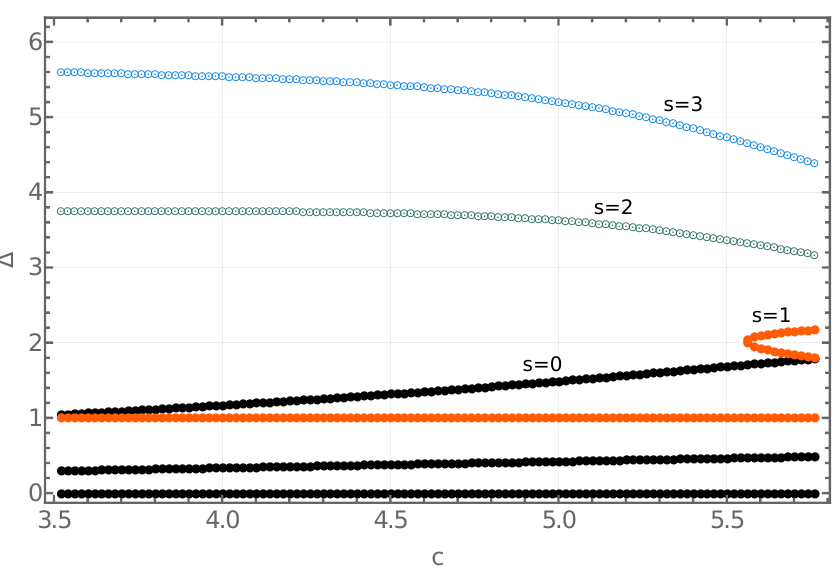
Figure 2 . Roots of the extremal functional evaluated at increasing values of the central charge. Single roots are denoted by filled circles and double roots are denoted by dotted